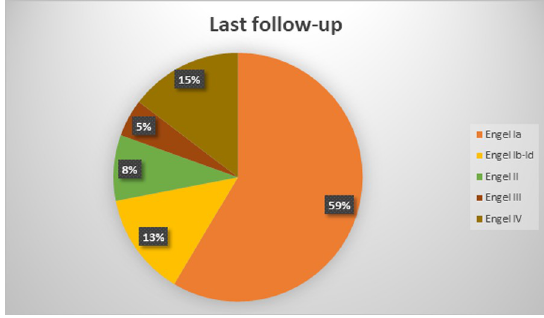
Fig 1. Long-term seizure outcomes. Last follow-up, 82 patients (Engel classification).